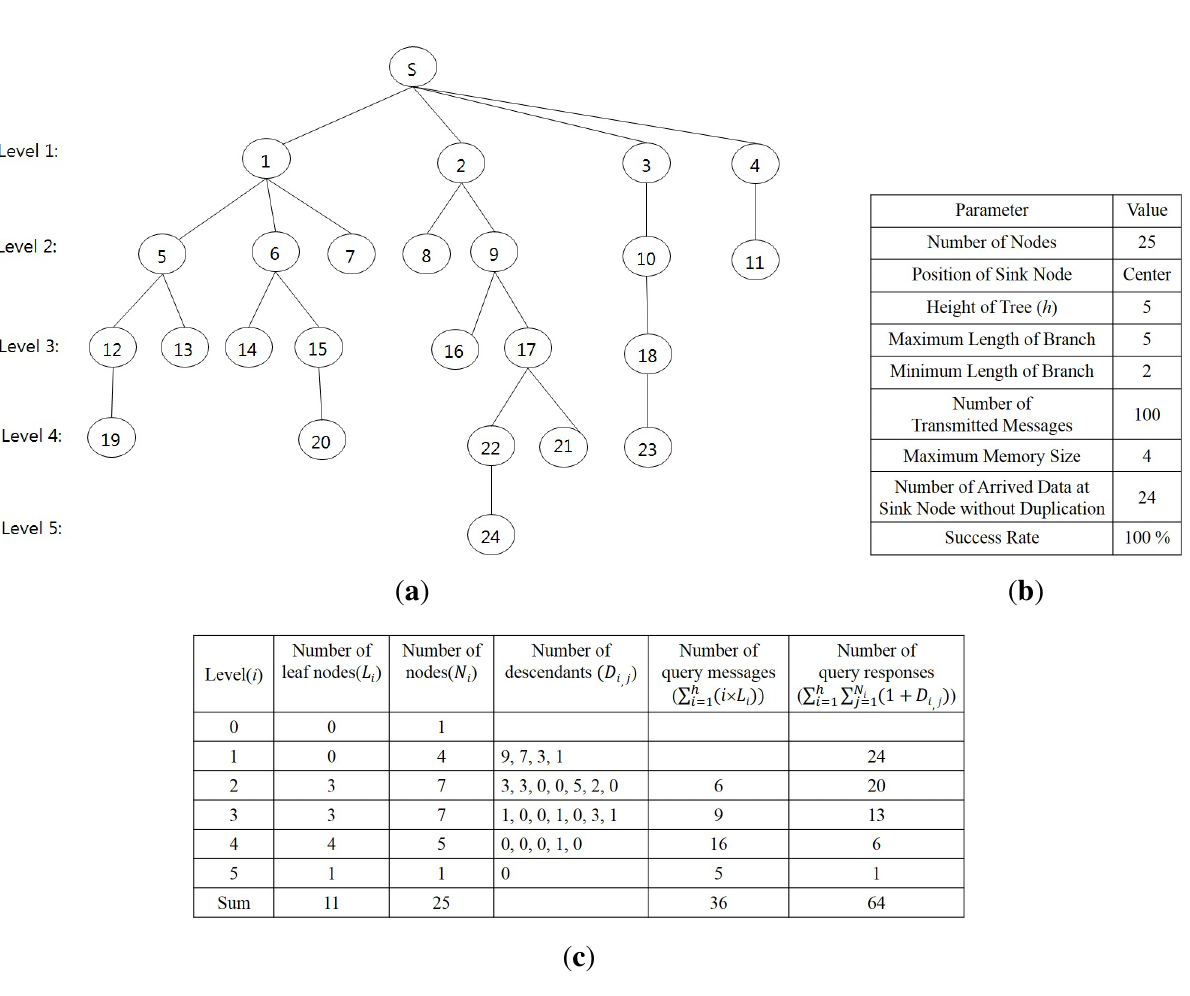
Figure 7. Results of the proposed method and Equation (5). ( a ) Tree structure; ( b ) Execution results of algorithms; ( c ) Number of leaf nodes, descendants and transmitted messages at each